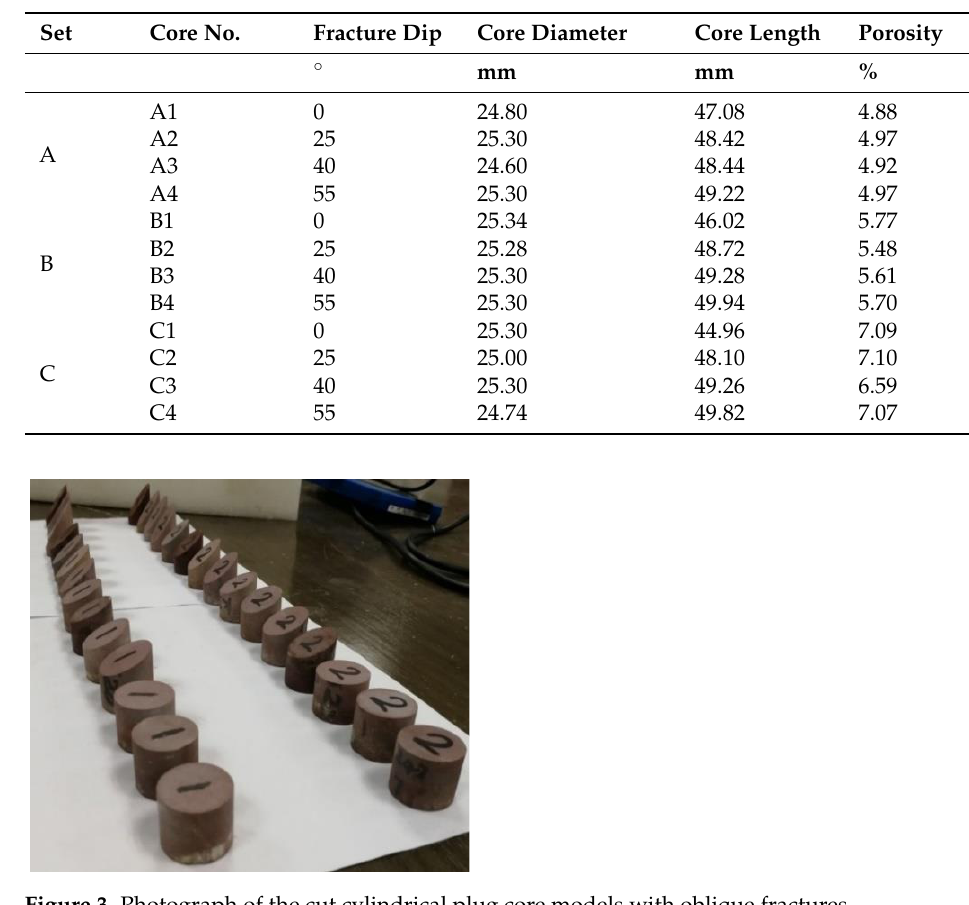
Table 1. Physical parameters of the experimental cores.